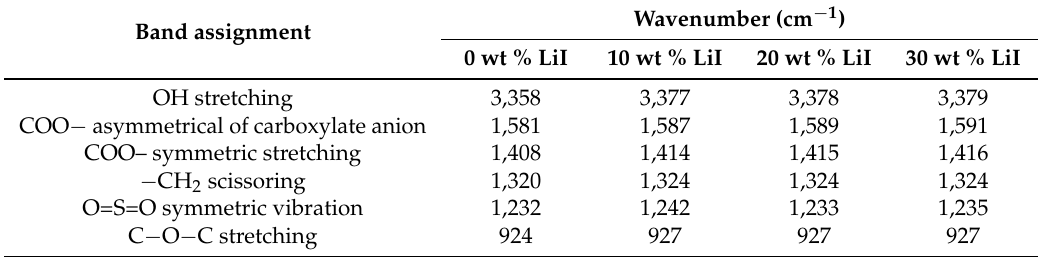
Table 1. FTIR band assignments and wavenumbers of CMKC/CMCE-based polymer electrolyte.